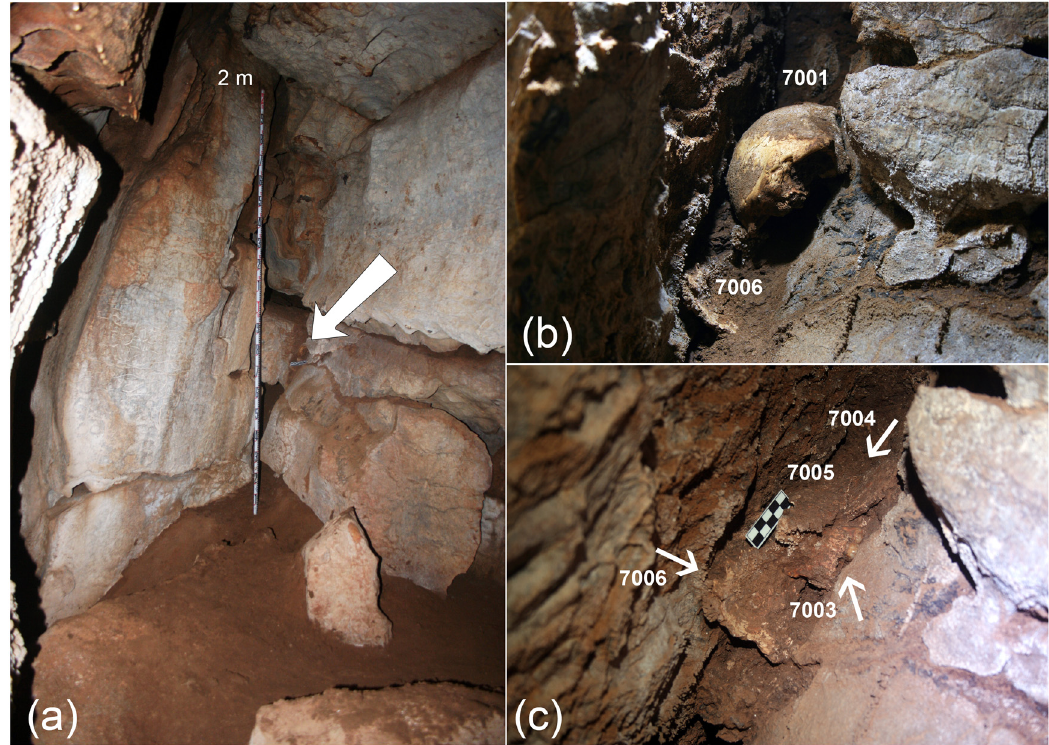
part of the human skull ( 7001 ) on - site. ( c ) View and position of highly cemented skull fragments placed below the frontal bone (